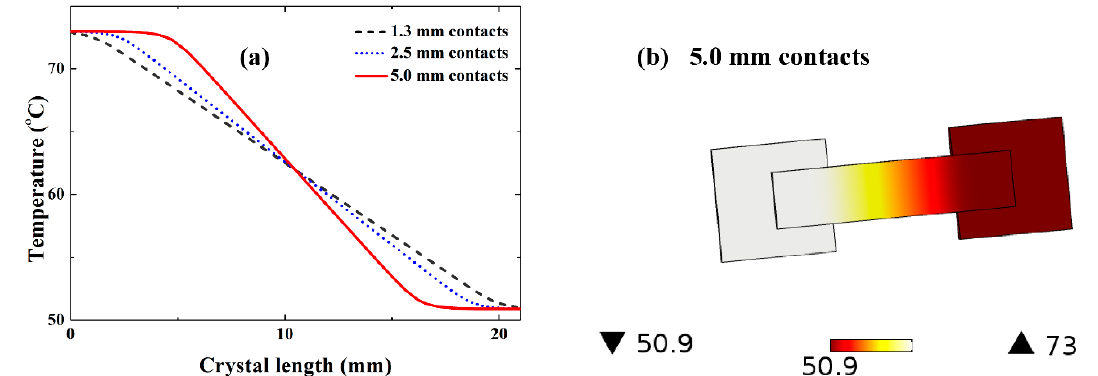
Figure 3. ( a ) Longitudinal temperature distribution in MgO:PPLN crystal for different contact lengths at the crystal ends; ( b ) false color image of the top view of the temperature (in °C) distribution along the PPLN crystal.